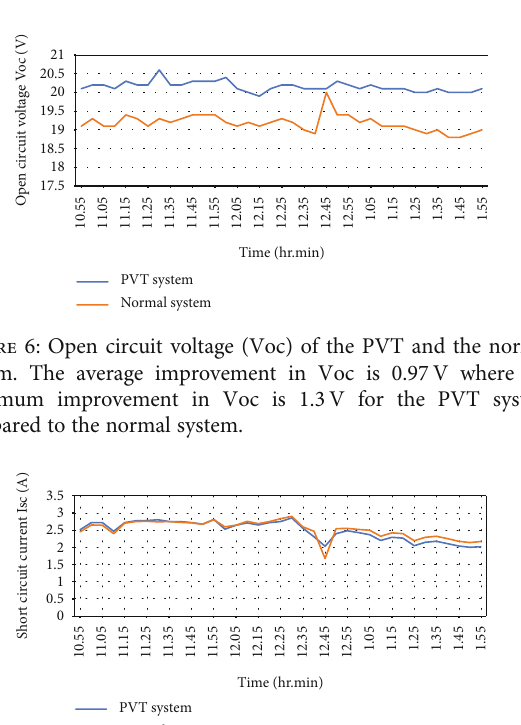
Figure 5: Temperature of air at inlet and outlet of the PVT system. Average di ff erence in temperature of inlet air and outlet air is 2.6 ° C, and maximum di ff erence in temperature is more than 4 ° C.